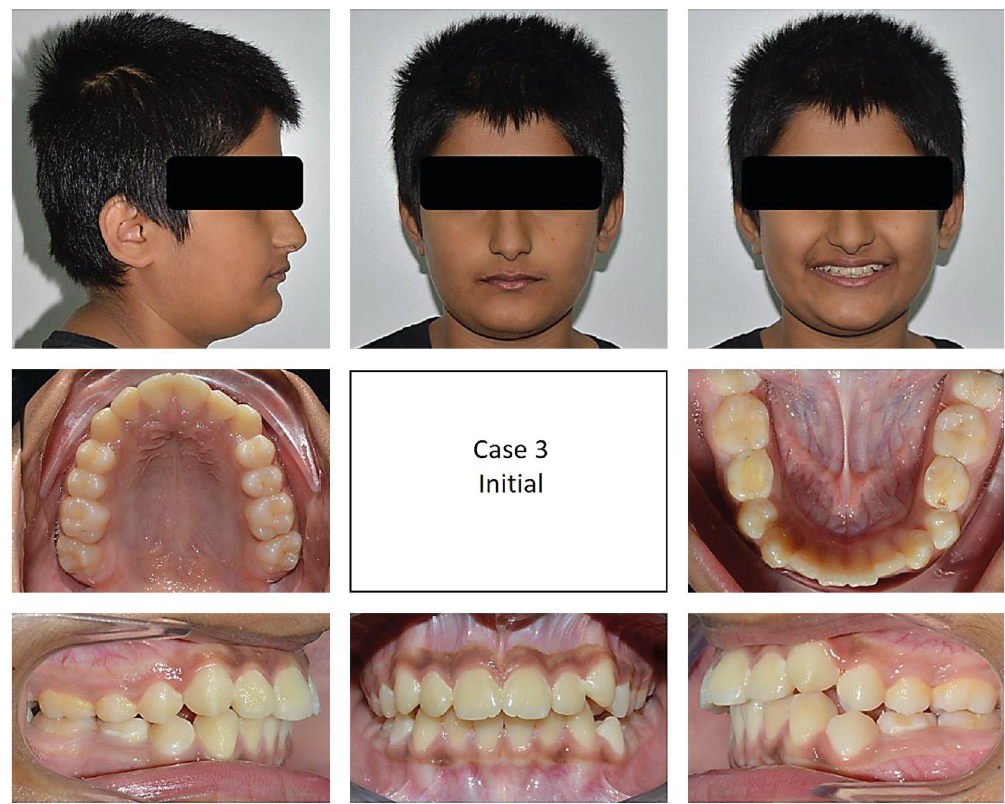
Figure 15: Pretreatment extraoral and intraoral photographs of the